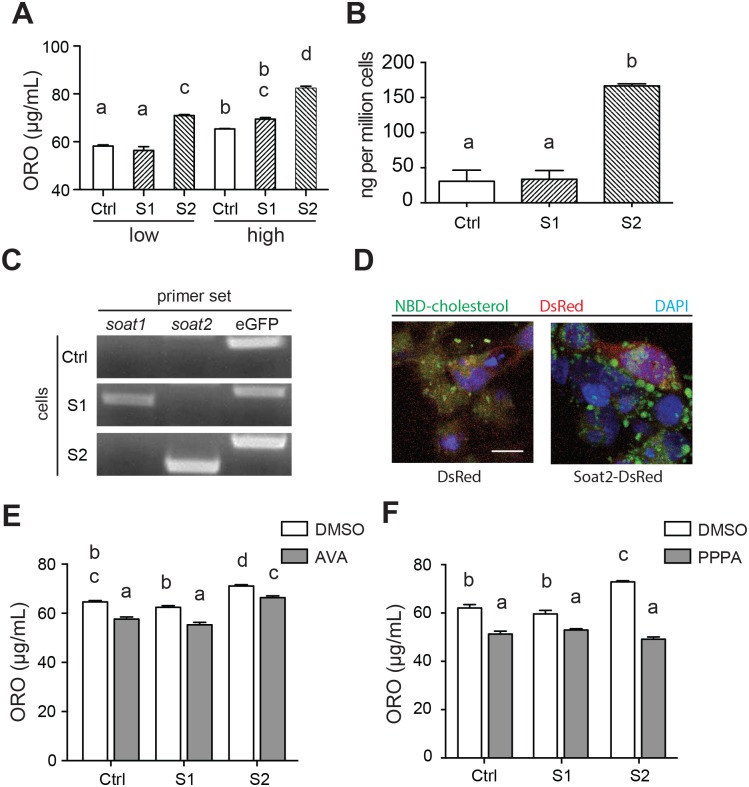
Increased intracellular accumulation of neutral lipid and CEs as a result of esterification of cholesterol to fatty acyl-CoA.(A) Oil Red O (ORO) staining of eGFP stable expressing (Ctrl), zebrafish saot1 stable expressing (Soat1), and zebrafish soat2 stable expressing (Soat2) HEK293 cells after incubation with low (15 μM oleic acids and 1 μg/mL cholesterol) or high (150 μM oleic acids and 10 μg/mL cholesterol) level of substrate at room temperature for 6 hrs. The expression of zebrafish Soat2 significantly increased the intracellular accumulation of neutral lipid indicated its enzymatic activity of cholesterol esterification, and this accumulation of neutral lipid is significantly increased with the increased levels of substrates. Note the significantly increased neutral lipid in WT-high compared to WT-low reflected the activity of endogenous human SOAT1 expressed by HEK293 cells. The letters above each column indicate the statistical groups, and the data sharing the same letters indicates no significant difference. (B) The cell lysate of HEK293 cells with zebrafish soat2 overexpression contained significantly higher CE content than either control group or soat1 overexpression group. Consistent with the ORO staining, the CE content in soat1 group was comparable to the control group. (C) RT-PCR confirmed the expression of both zebrafish soat1 and eGFP in Soat1-overexpressing HEK293 cells, zebrafish soat2 and eGFP in Soat2-overexpressing HEK293 cells and only eGFP in control group in which the HEK293 cells were transfect with empty vectors. (D) The HEK293 cells overexpressing zebrafish Soat2 (Soat2-DsRed) contained more and larger intracellular lipid droplets containing NBD-cholesterol as compared to the HEK293 cells overexpressing DsRed only (DsRed). (E) Avasimibe (AVA) significantly reduced the intracellular accumulation of neutral lipid, but the cells with zebrafish soat2 overexpression still showed a significantly more ORO staining than other AVA-treated cells. (F) Pyripyropene A (PPPA) could significantly reduce the intracellular accumulation of neutral lipid by inhibiting the enzymatic activity of both endogenous human SOAT1 and zebrafish Soat2 when compared to the vehicle control (DMSO). The letters above each column indicate the statistical groups, and the data sharing the same letters indicates no significant difference.